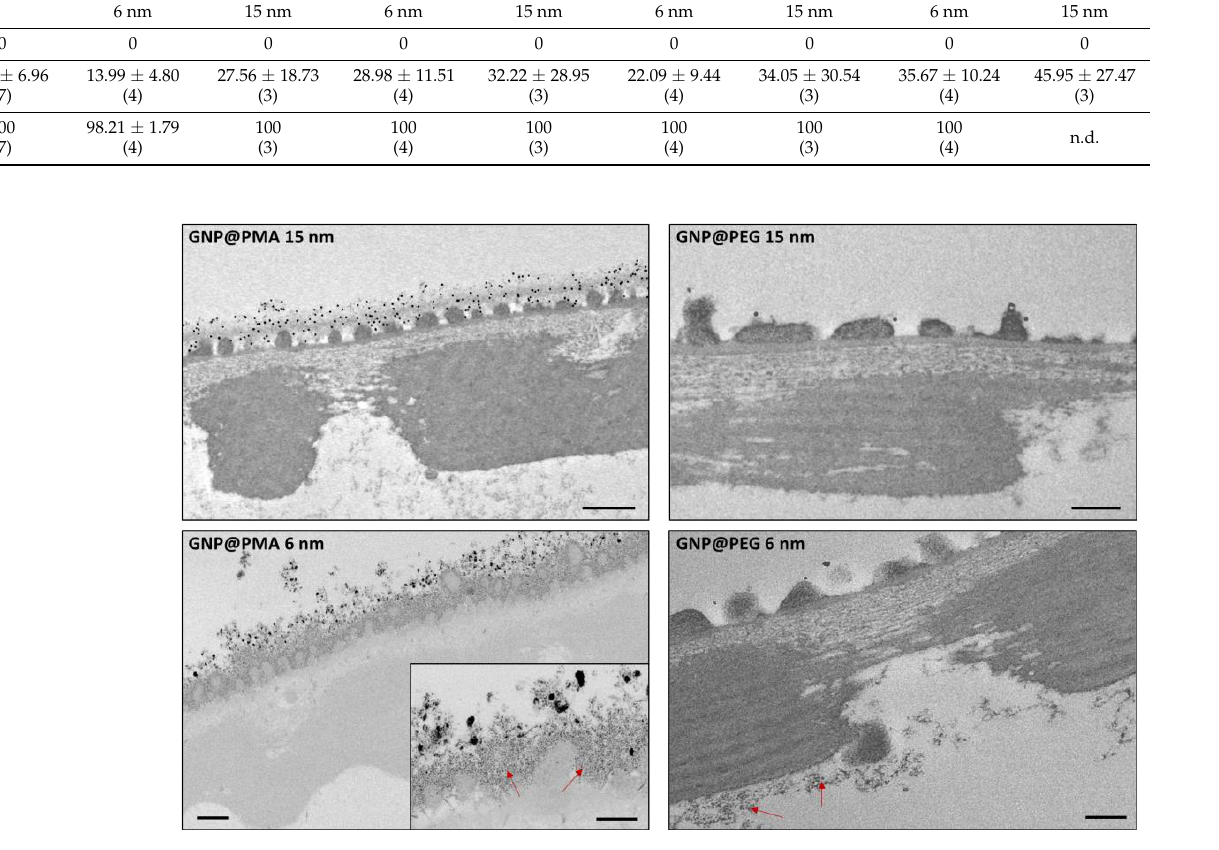
Figure 4. TEM images of zebrafish embryos (48 hpf) incubated with 6 nm or 15 nm GNP@PMA or GNP@PEG, at a concentration of 1 nM. The high-magnification insert highlights a great amount of dispersed 6 nm GNP@PMA on the chorion surface (red arrows); blue arrows indicate rare 15 nm GNP@PEG or 6 nm GNP@PEG aggregates on the chorion surface. Bars = 500 nm in the figures of GNP@PMA and 200 nm in the figures of GNP@PEG and in the insert of 6 nm GNP@PMA.